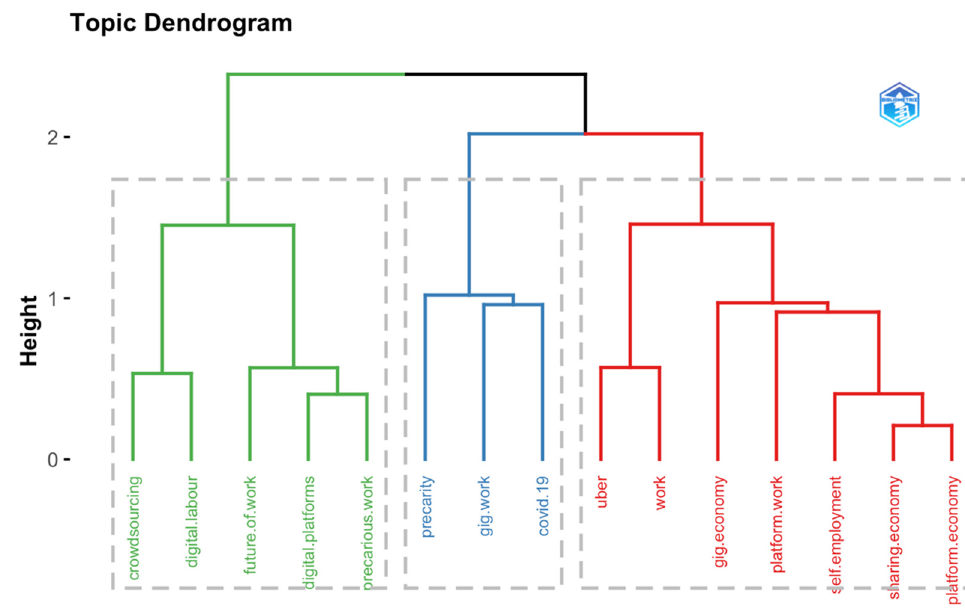
Figure 9. The dendrogram.